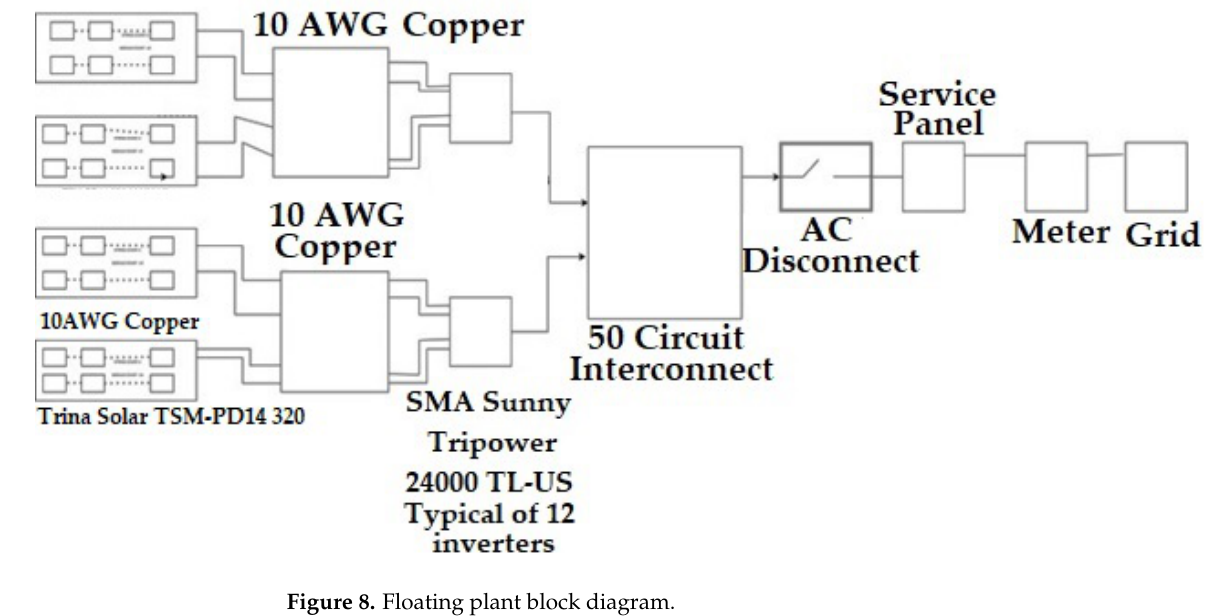
Figure 8. Floating plant block diagram.